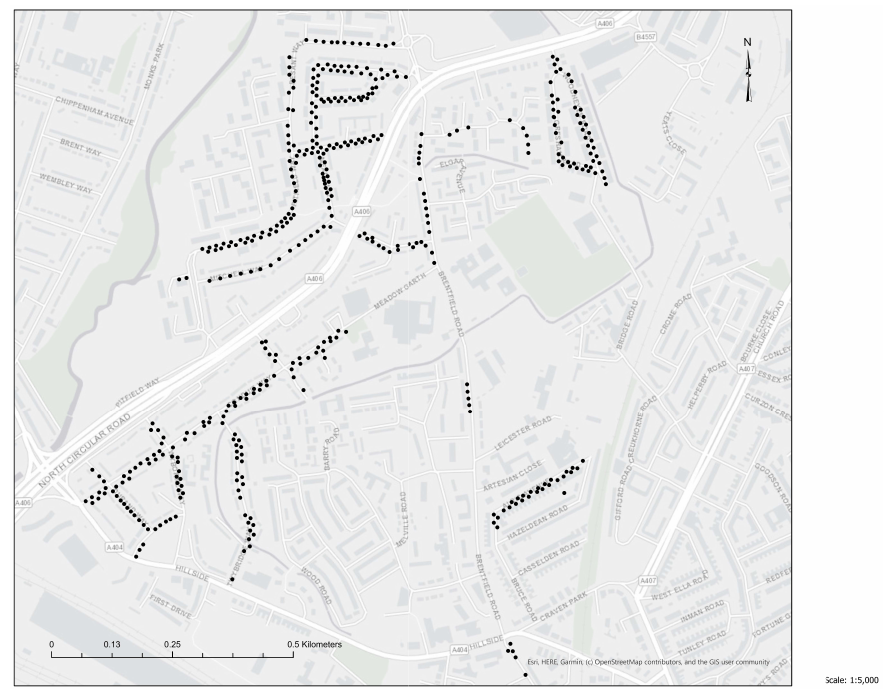
Figure 2. A total of 493 MPT spots in secondary streets were identified inside the Ward. Nonetheless, more trees can be located in existing parks, residual spaces, parking lots, and